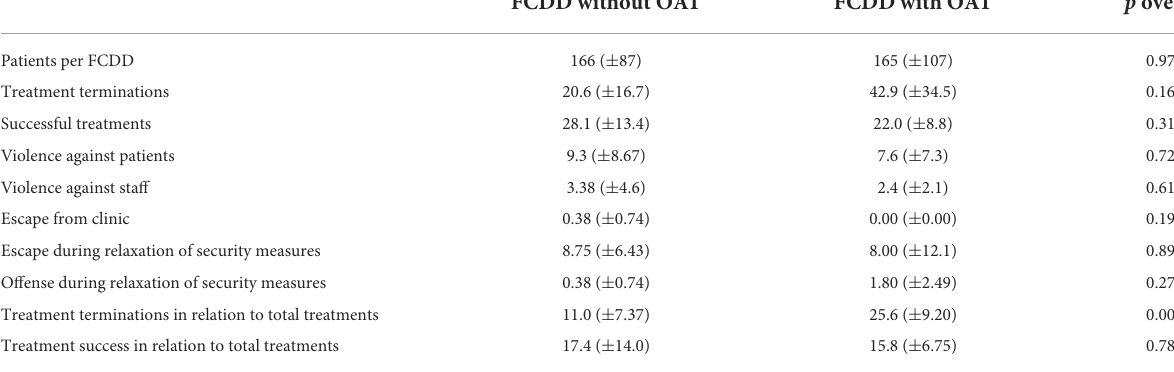
TABLE 4 Comparison of FCDD with and without an OAT program in 2018 (mean with standard deviation). FCDD without OAT FCDD with OAT p